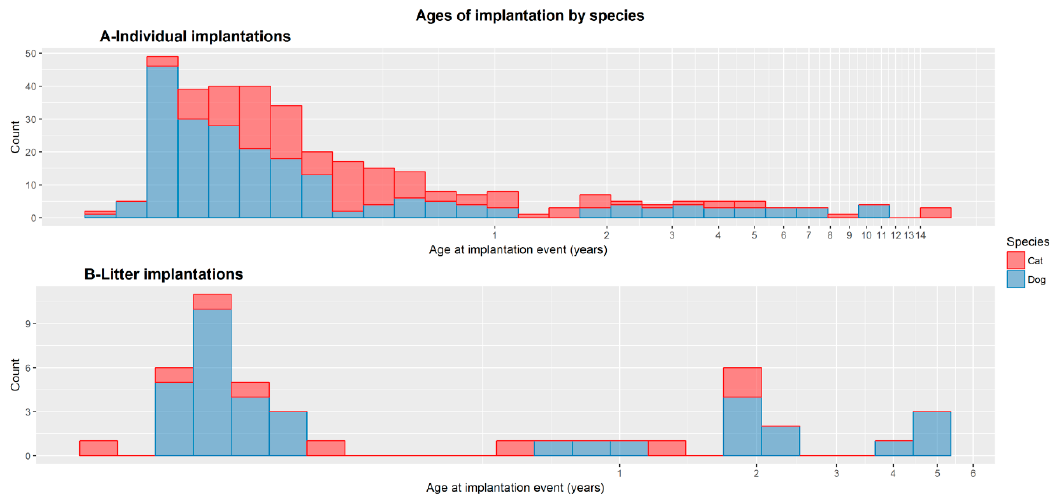
Figure 2. A and B: Showing the apparent age at microchip implantation for both dogs and cats in the electronic patient records for ( A ) individuals and ( B ) litters. Red = cats, blue = dogs.